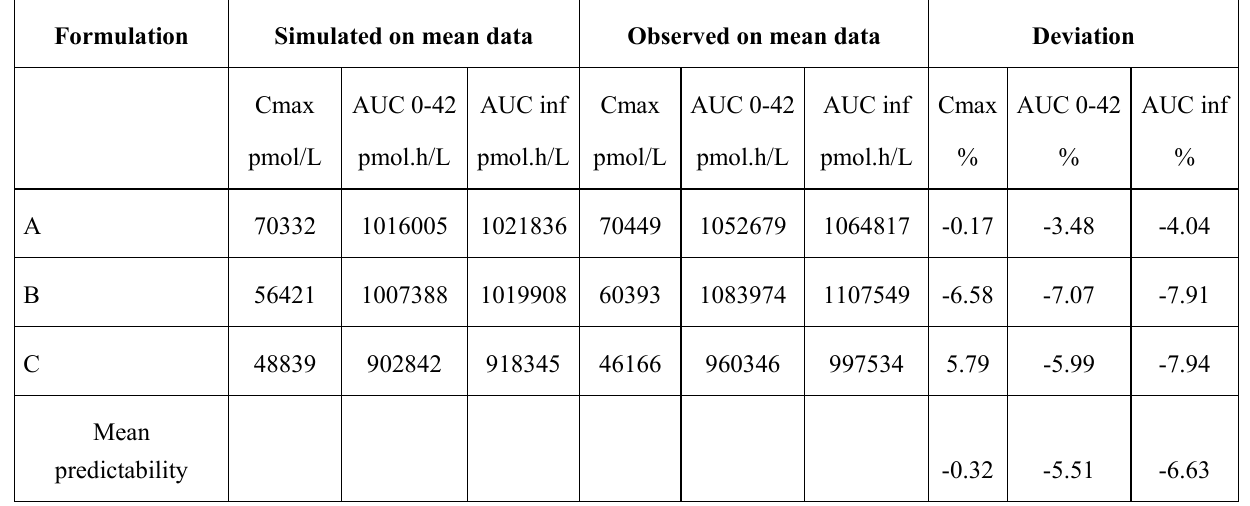
Table 3. Predictability based on AUC and Cmax of the mean